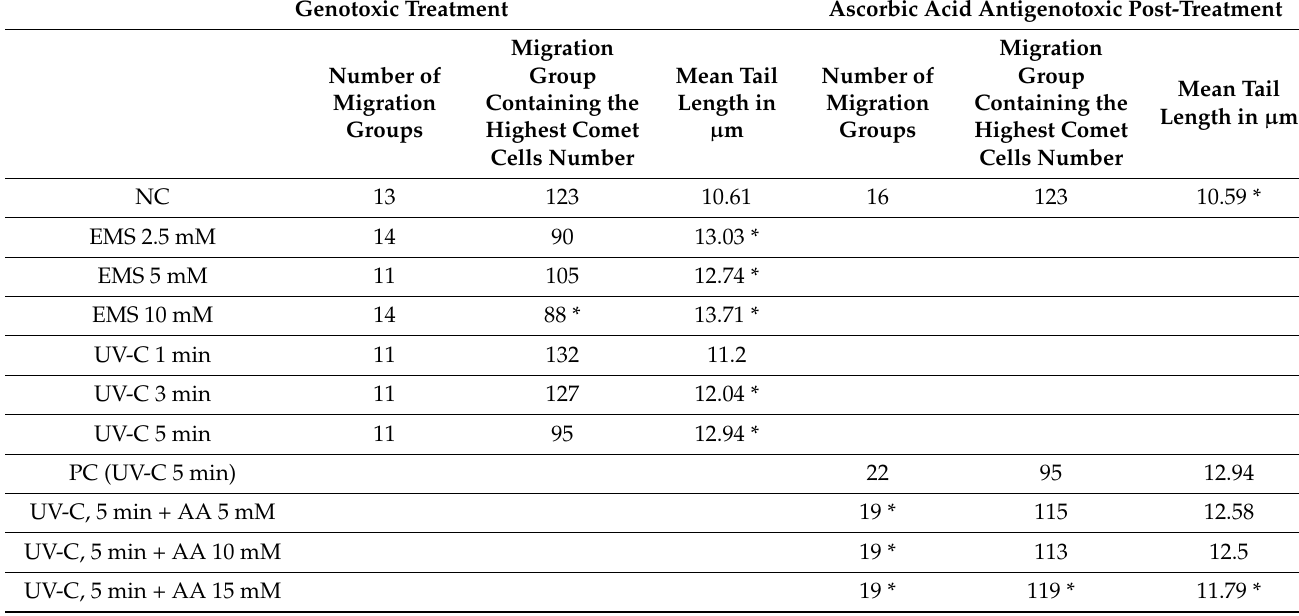
Table 2. Genotoxic and antigenotoxic treatments in Ambystoma mexicanumn erythrocytes. The genetic damage was observed using the number of migration groups, the migration groups with the highest comet cell number, and mean tail length observed in each